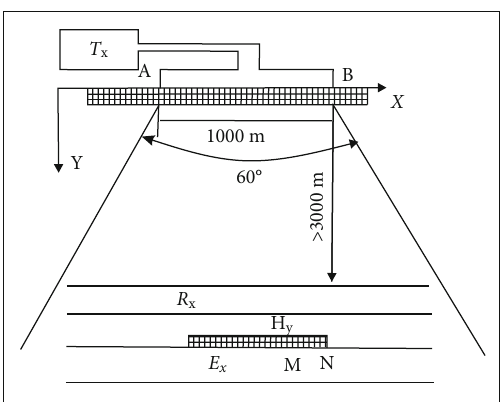
Figure 10: Schematic diagram of a CSAMT device on the ground.